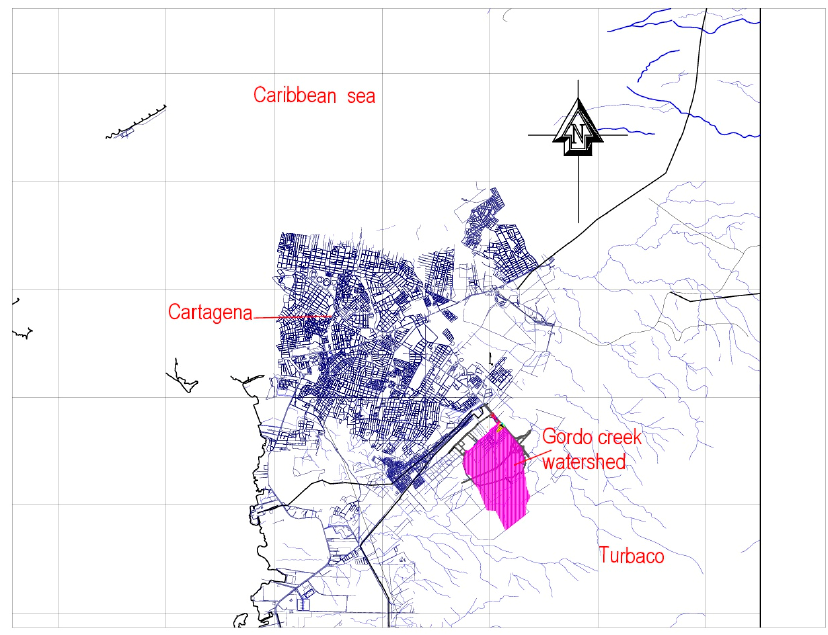
Figure 1. Study area location.